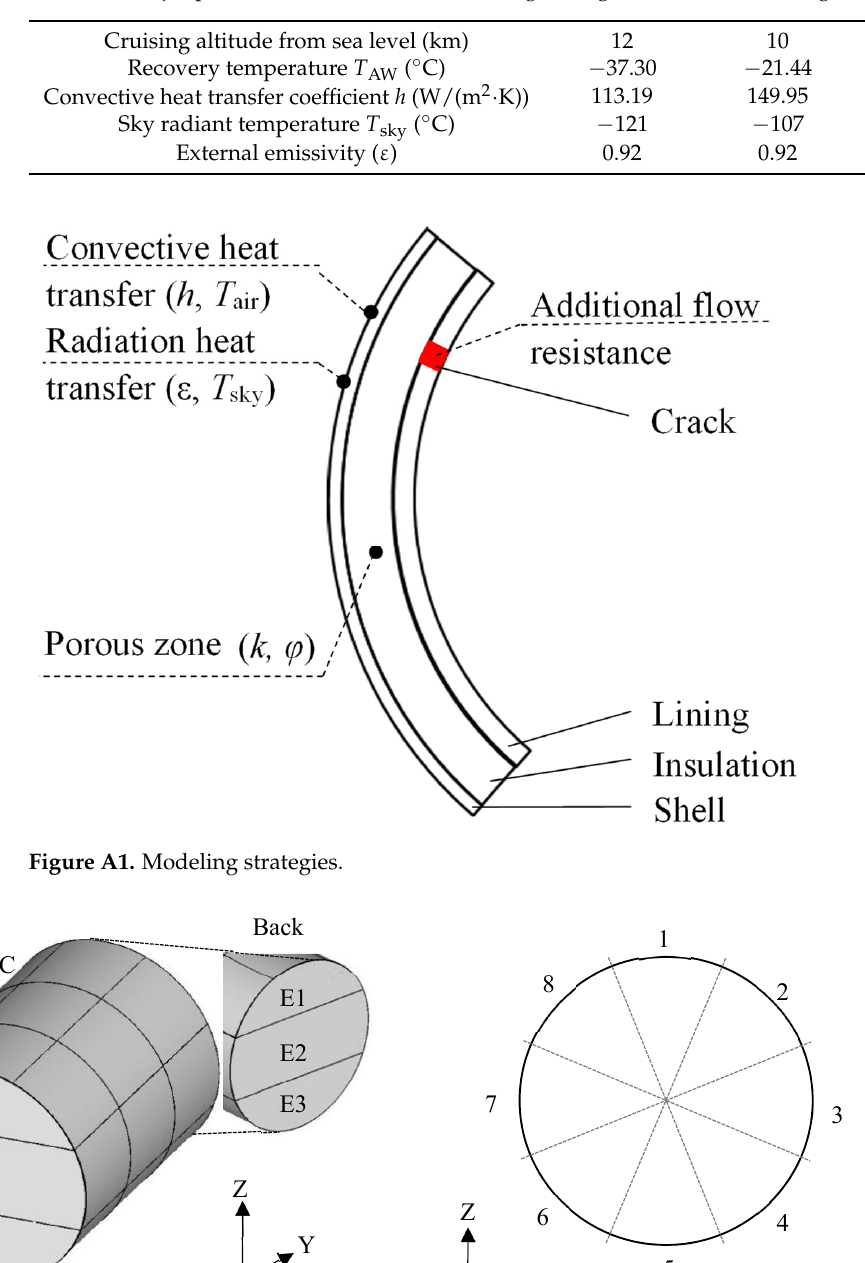
Table A1. Major parameters used in CFD modeling for flight at different cruising altitudes.